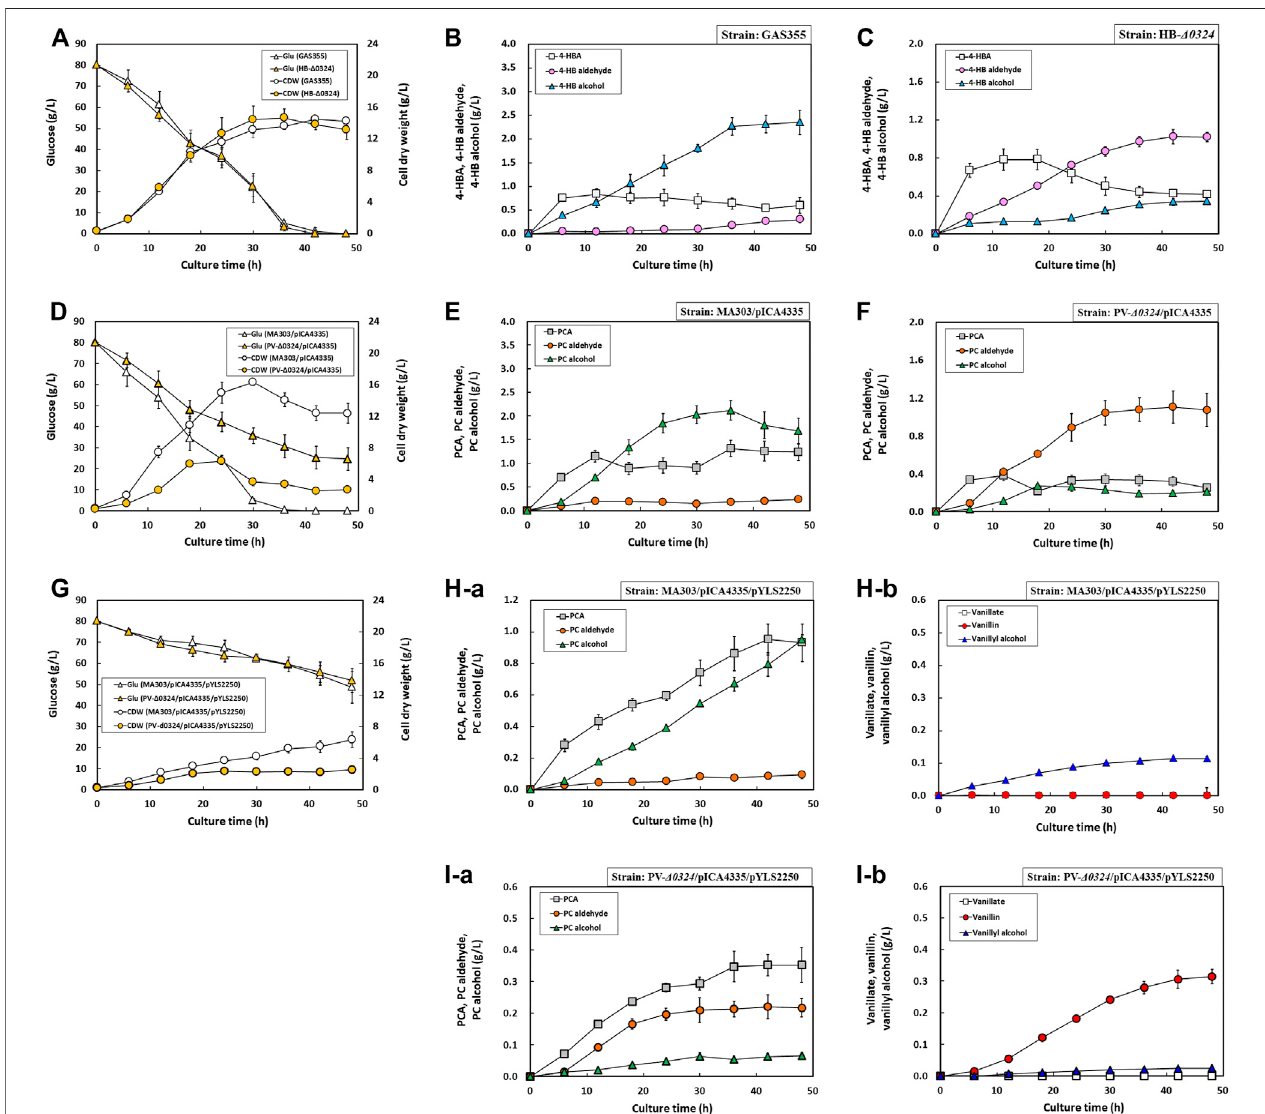
FIGURE6| Growthand production pro fi lesof C.glutamicum mutantstrainsfor48 hin fl askculture. (A) Growth andglucoseconsumptionpro fi lesofGAS355 and HB- Δ 0324 strains for 48 h. (B) Production pro fi les of 4-HBA, 4-HB aldehyde, and 4-HB alcohol by GAS355 for 48 h. (C) Production pro fi les of 4-HBA, 4-HB aldehyde, and4-HBalcoholbyHB- Δ 0324 for48 h. (D) Growthandglucoseconsumptionpro fi lesofstrainsMA303andPV- Δ 0324 withplasmidpICA4335for48 h. (E) Production pro fi les of PCA, PC aldehyde, and PC alcohol by MA303 with pICA4335 for 48 h. (F) Production pro fi les of PCA, PC aldehyde, and PC alcohol by PV- Δ 0324 with pICA4335 for 48 h. (G) Growth and glucose consumption pro fi les of strains MA303 and PV- Δ 0324 with plasmids pICA4335 and pYLS2250 for 48 h (H – a) Production pro fi les of PCA, PC aldehyde, and PC alcohol by MA303 with pICA4335 and pYLS2250 for 48 h (H – b) Production pro fi les of vanillate, vanillin, and vanillyl alcohol by MA303withpICA4335andpYLS2250for48 h (I – a) Productionpro fi lesofPCA,PCaldehyde,andPCalcoholbyPV- Δ 0324 withpICA4335andpYLS2250for48 h (I – b) Productionpro fi les ofvanillate, vanillin,and vanillyl alcohol byPV- Δ 0324 withpICA4335and pYLS2250for48 h. Mostcells weregrown in fl askfermentationmedium for 48 h at 32 ° C with vigorous shaking at 240 rpm. MA303 and PV- Δ 0324 with pICA4335 and pYLS2250, respectively, were cultivated in supplementary medium with 0.5 g/L L -methionine. Mean and standard deviation of triplicate cultivation are